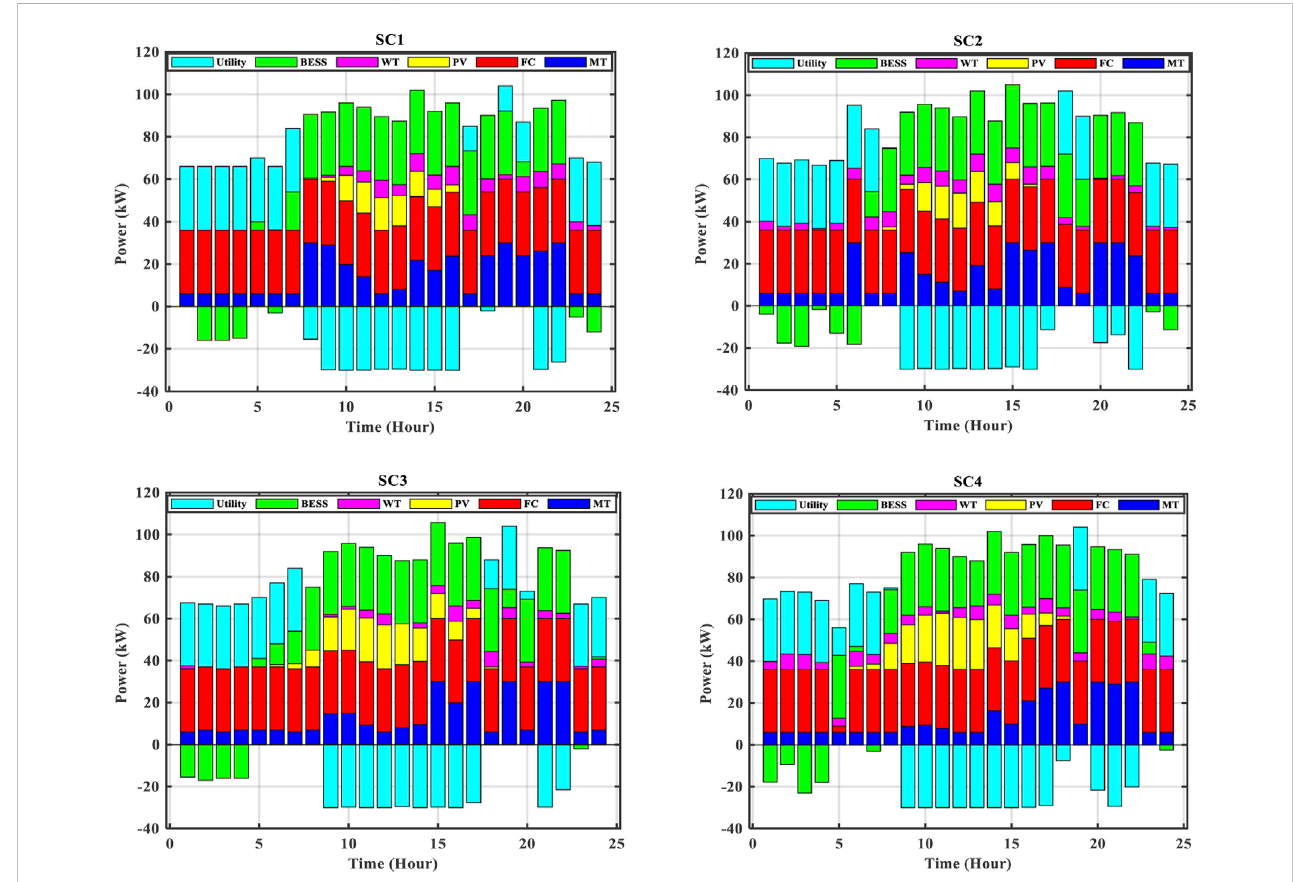
FIGURE 8 Case 3 with 10%